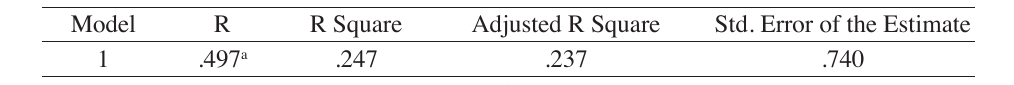
Table 6: Impact of Reward on Employee Intention To Leave Model R R Square Adjusted R Square Std. Error of the Estimate .497 a .247 .237 .740